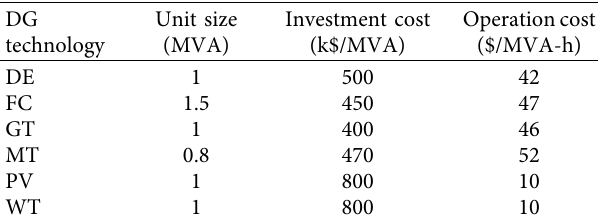
Table 7: Data of six DG technologies.